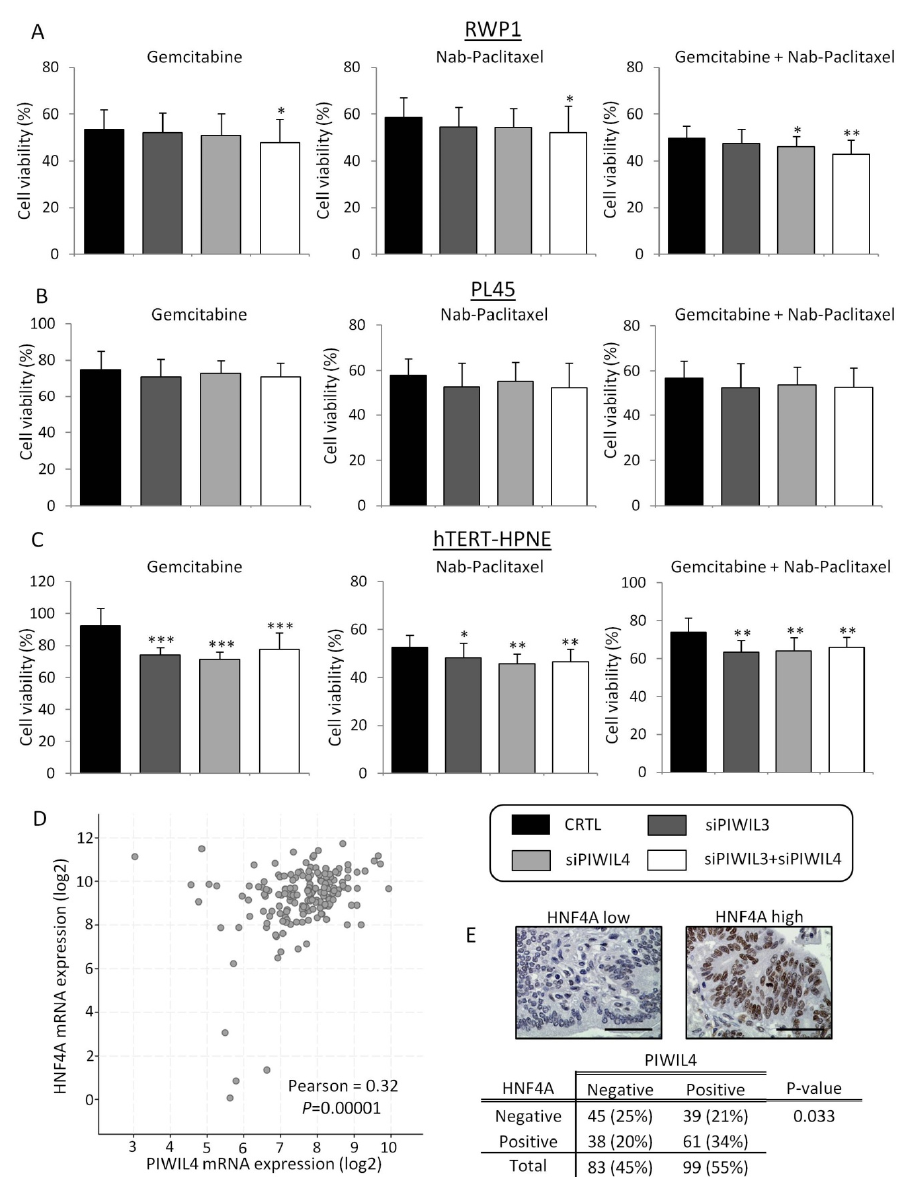
Figure 4. PIWIL3 and PIWIL4 downregulation potentiates the cytotoxic effect of chemotherapy. ( A ) Cell viability analyses after PIWIL3 and/or PIWIL4 silencing according to Gemcitabine (left) or Nab-Paclitaxel (center) individual treatments or in combination (right) of RWP1 cell line, PL45 ( B ) and hTERT-HPNE ( C ) cell lines. ( D ) Scatterplot and statistical analysis of HNF4A mRNA expression (y axis) and PIWIL4 mRNA expression (x axis) of 178 patient cohort from The Cancer Genome Atlas (TCGA). ( E ) Representative micrographs of HNF4A low expression (top-left) and high expression top-right). Statistical association between HNF4A and PIWIL4 protein expression of 182 PC samples (bottom). Color-coding for each protein downregulation is indicated in the legend box. Scale bars: 50 µm. * p < 0.05; ** p < 0.01; *** p < 0.001.